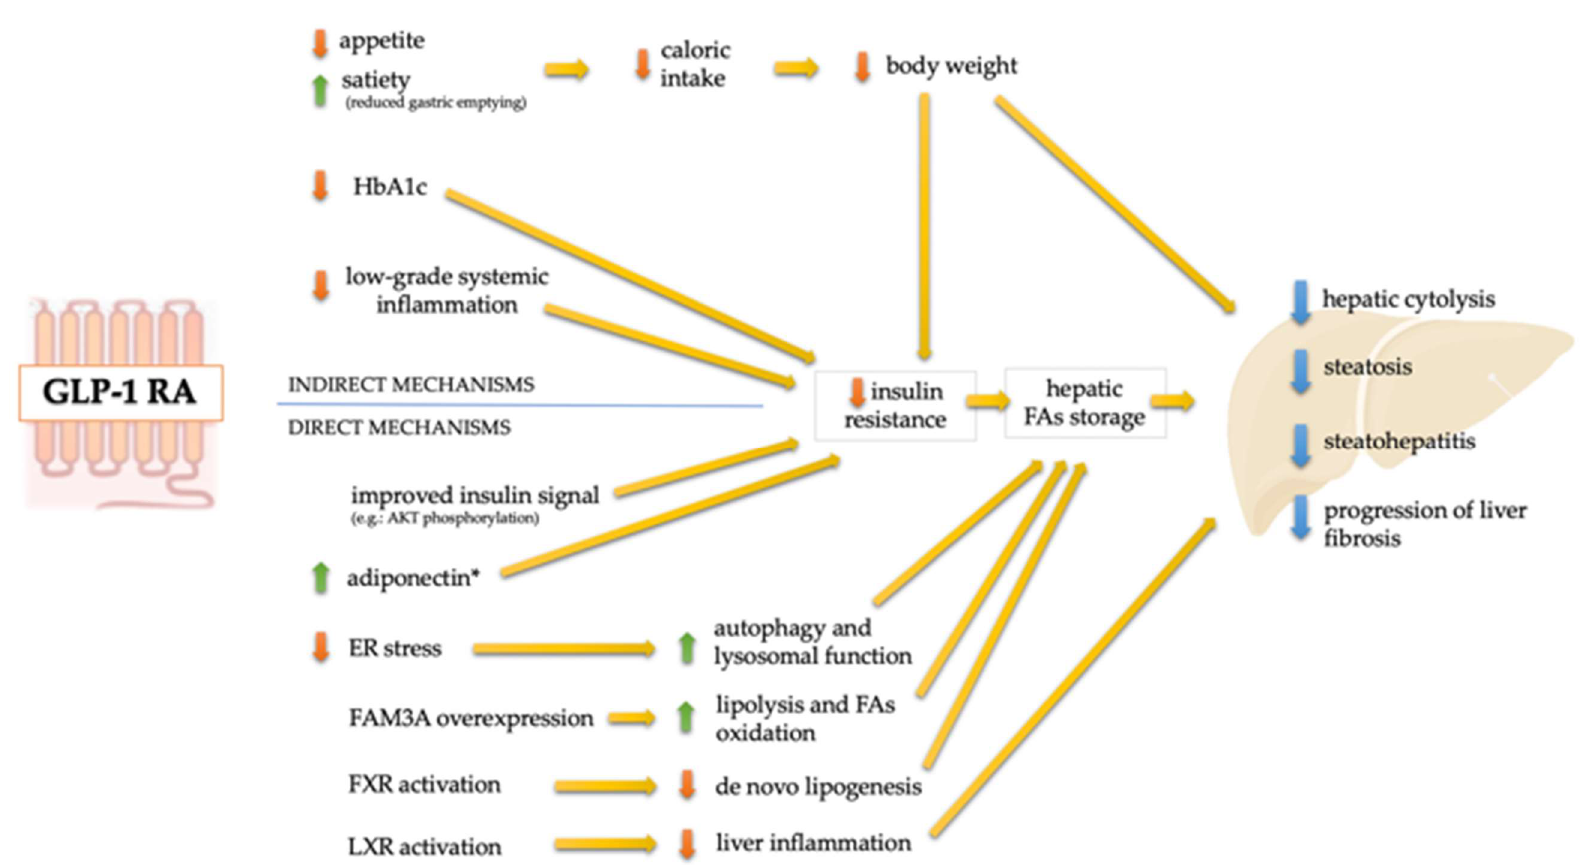
Figure 1. Direct and indirect mechanisms of action of GLP-1 RAs potentially involved in the NAFLD treatment. ER: endoplasmic reticulum; FAs: fatty acids; FAM3A: family with sequence similarity 3 member A; FXR: farnesoid X receptor; HbA1c: glycosylated hemoglobin; LXR: liver X receptor. * also determined by the reduction in body weight.